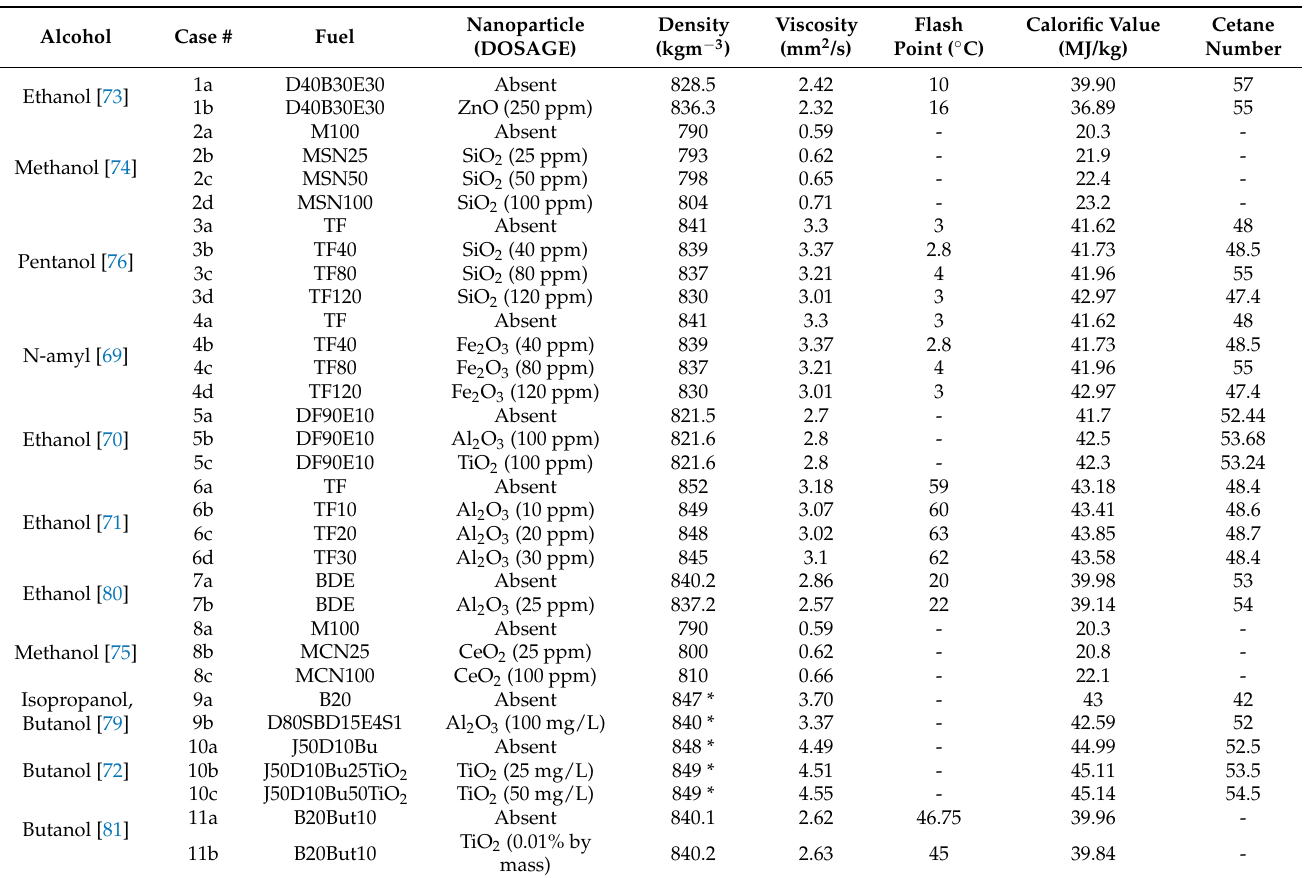
Table 1. Summary of nanoparticles’ effect on fuel properties of alcohol-based